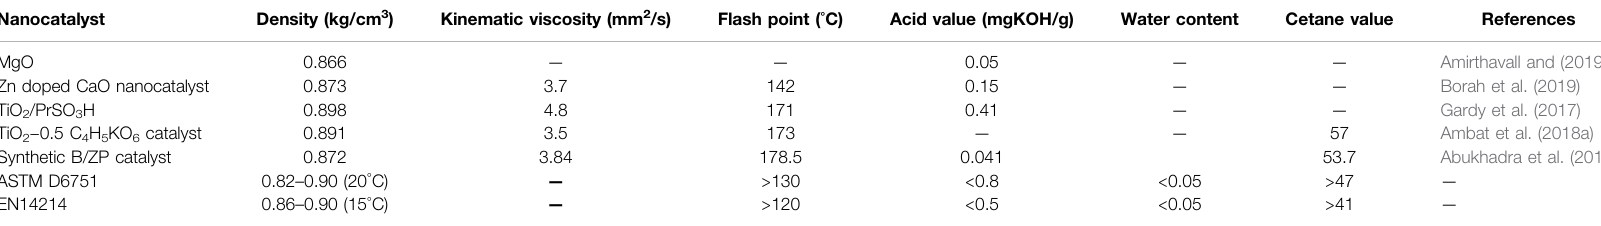
TABLE 7 | Comparison of the physico-chemical properties of biodiesel derived from different nanocatalysts with standard methods.